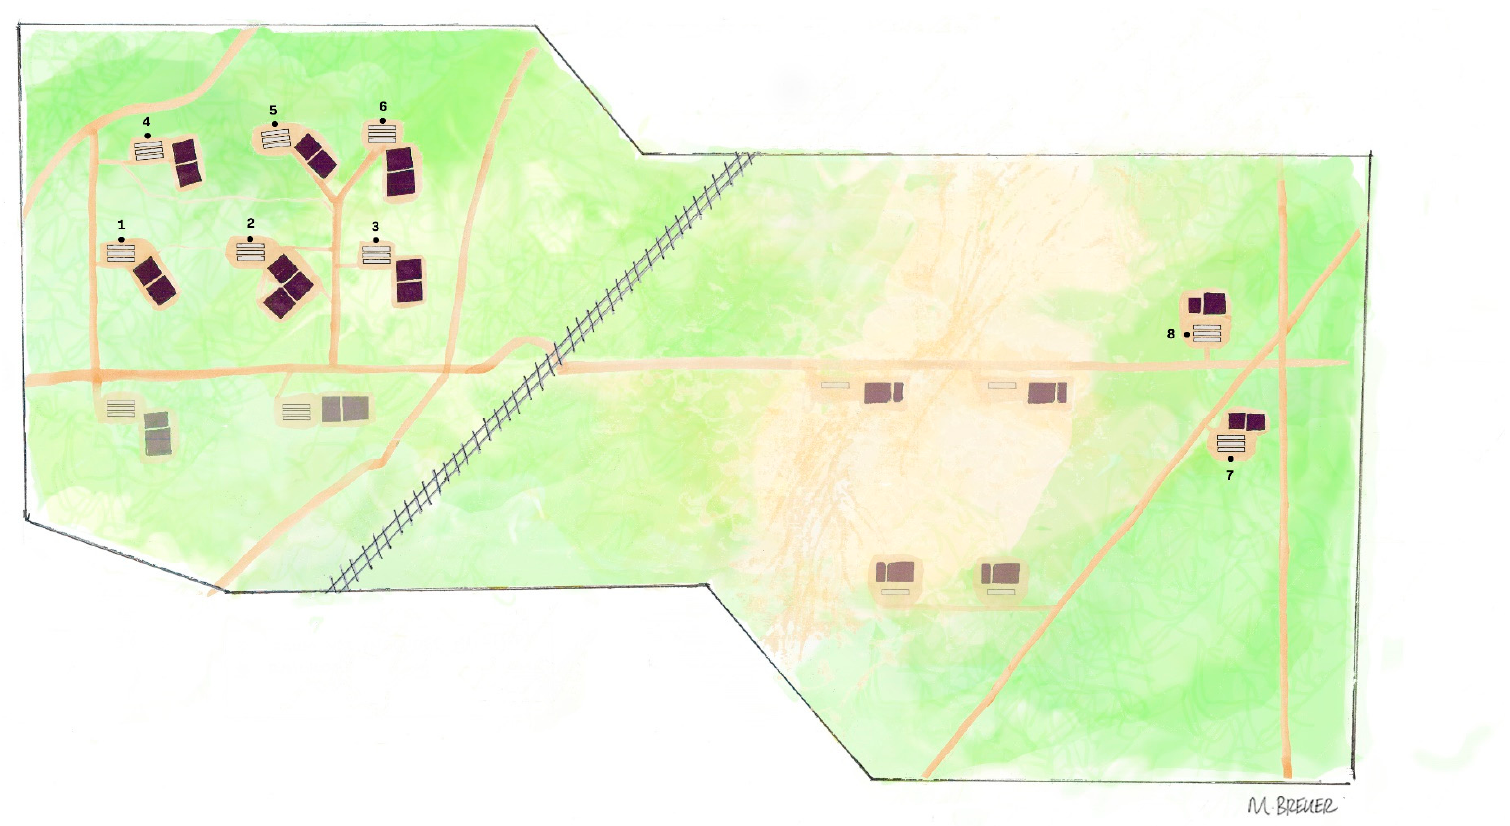
Figure 1. Aerial diagram showing wean-to-finish (WTF) sites of the production system studied. Area 1 (upper left) contains six WTF sites: 1, 2, 3, 4, 5 and 6. Area 2 (right) contains two WTF sites: 7, 8. Two of the six breeding-gestating-farrowing (BGF) sites that supplied the weaned pigs are located in the lower left below area 1.